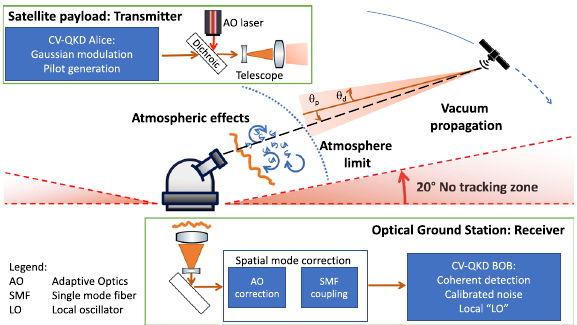
Fig. 1 Schematic diagram of the CV-QKD communication scheme analyzed in this work. A fi xed ground station (Bob) follows the trajectory of a satellite (Alice), equipped with a tracking system, passing over its zenith point. An adaptive optics (AO) system is required in order to correct the wavefront distortions due to the atmosphere and maximize the signal to noise ratio at the receiver. The exact implementation of this system is beyond the scope of this work. The parameters θ p , θ d are explained in the